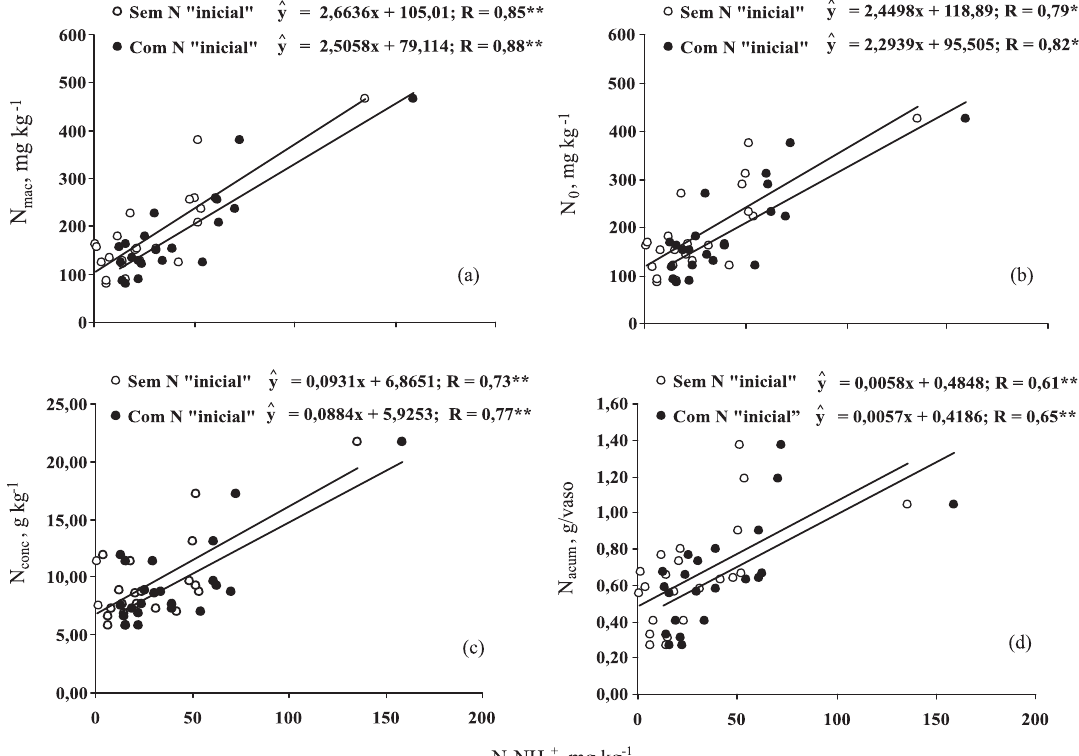
Figura 2. Correlações entre quantidades de N-NH 4+ obtidas após incubação anaeróbia por sete dias e N mineralizado acumulado em 30 semanas de incubação aeróbia (N ) (a), N potencialmente mineralizável mac (N ) (b), concentração (N ) (c) e acúmulo de N (N ) (d) na matéria seca da parte aérea das plantas 0 conc acum de milho. **: significativo a 1